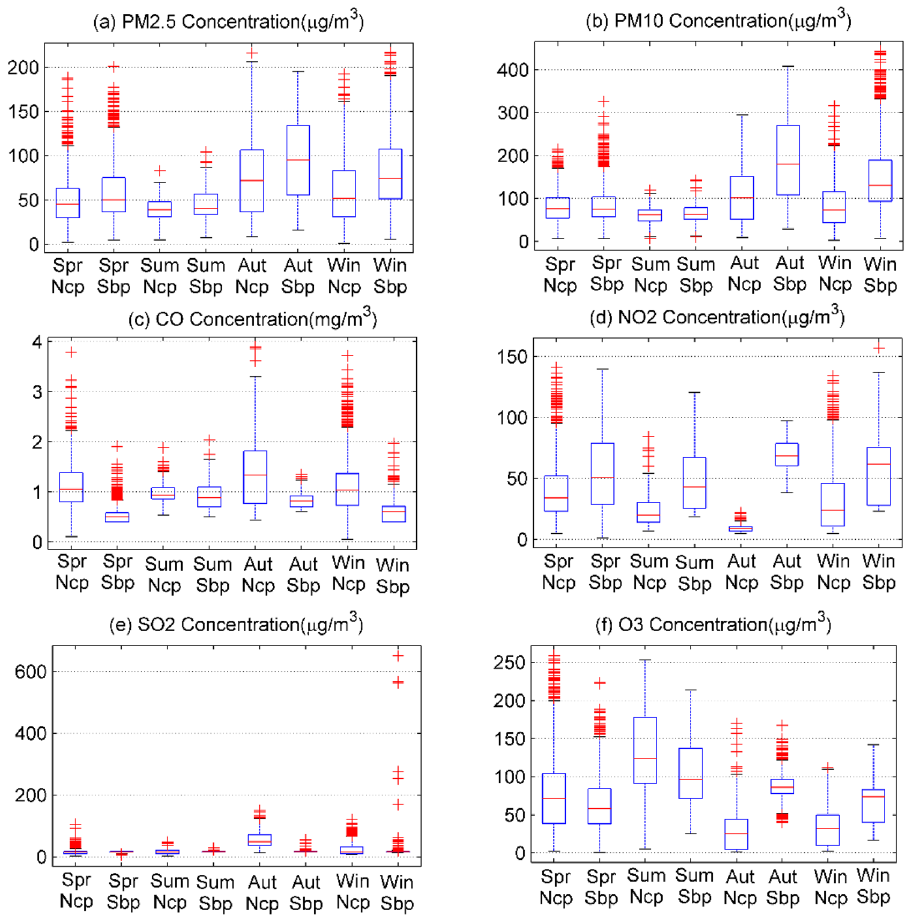
Figure 3. Comparing the concentration of six types of pollutants at national control sites (Ncp) and self-built sites (Sbp) on a seasonal basis.